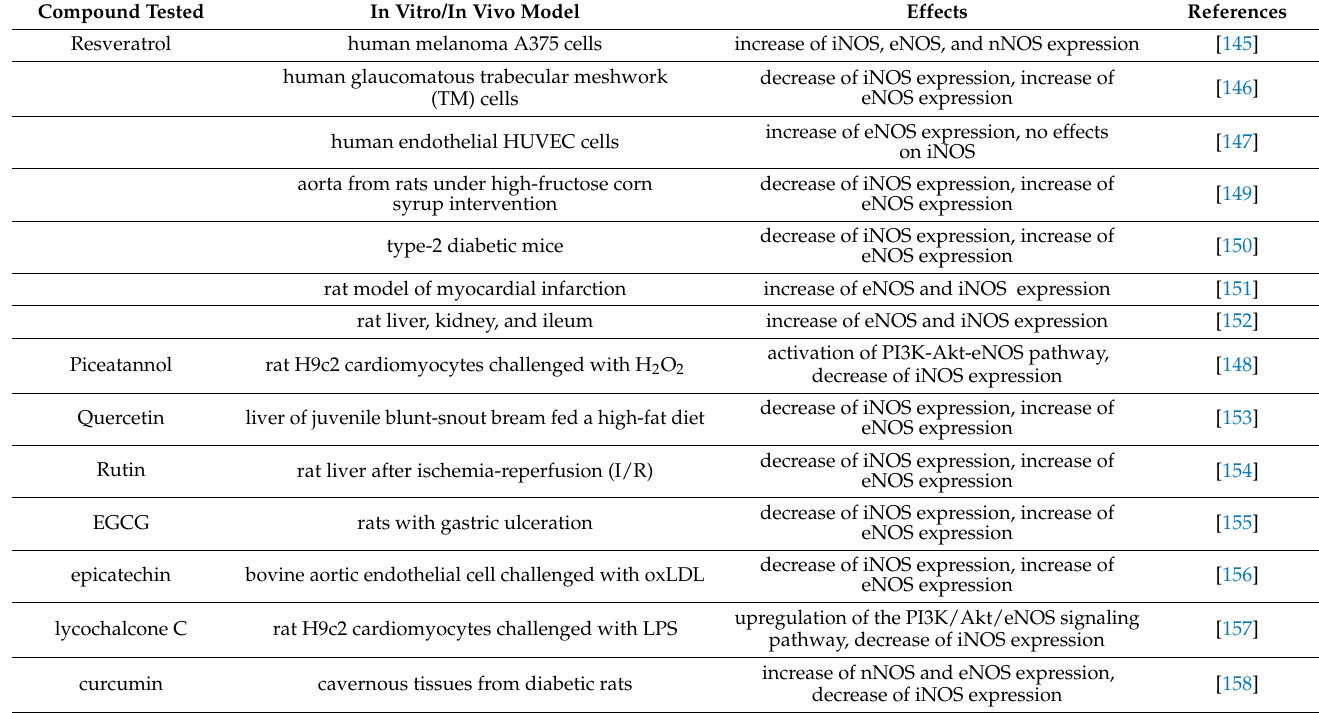
Table 1. Simultaneous effects on different NOS isoforms exerted by